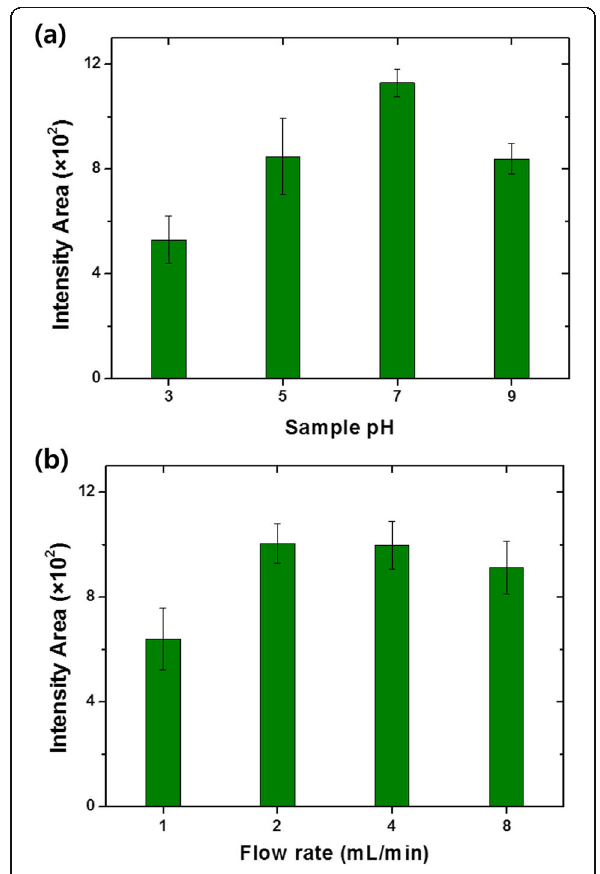
Fig. 2 The signal intensity of Se (VI) from LIBS spectra. a Signal intensities of Se (VI) at different pH values (3.0, 5.0, 7.0, and 9.0) and b those at different flow rates (1.0, 2.0, 4.0, and 8.0 mL/min). A 10-mL solution was used for each